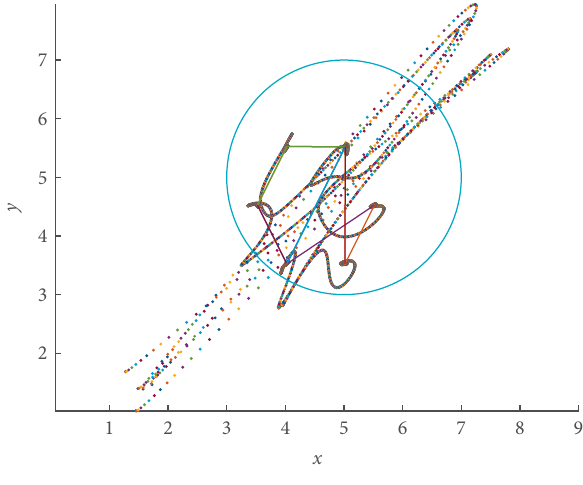
Figure 3: The motion trajectory of a six-agent.